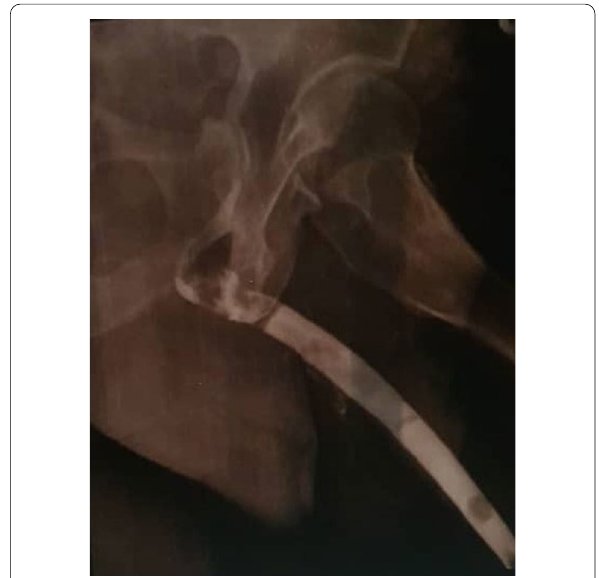
Fig. 1 Retrograde urethrogram showing multiple irregular filling defects in the anterior urethra with contrast intravasation, most